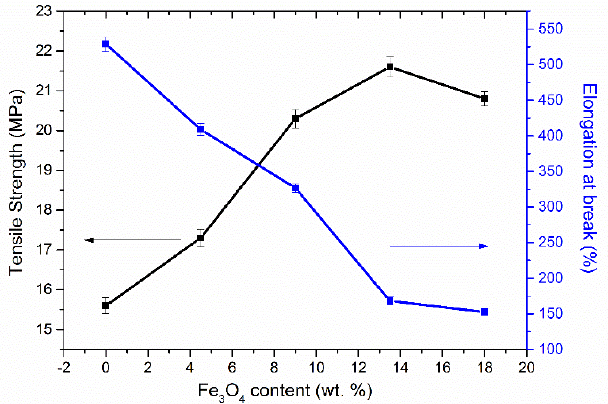
Figure 3. Mechanical properties of Fe 3 O 4 /SBS/LLDPE composites.